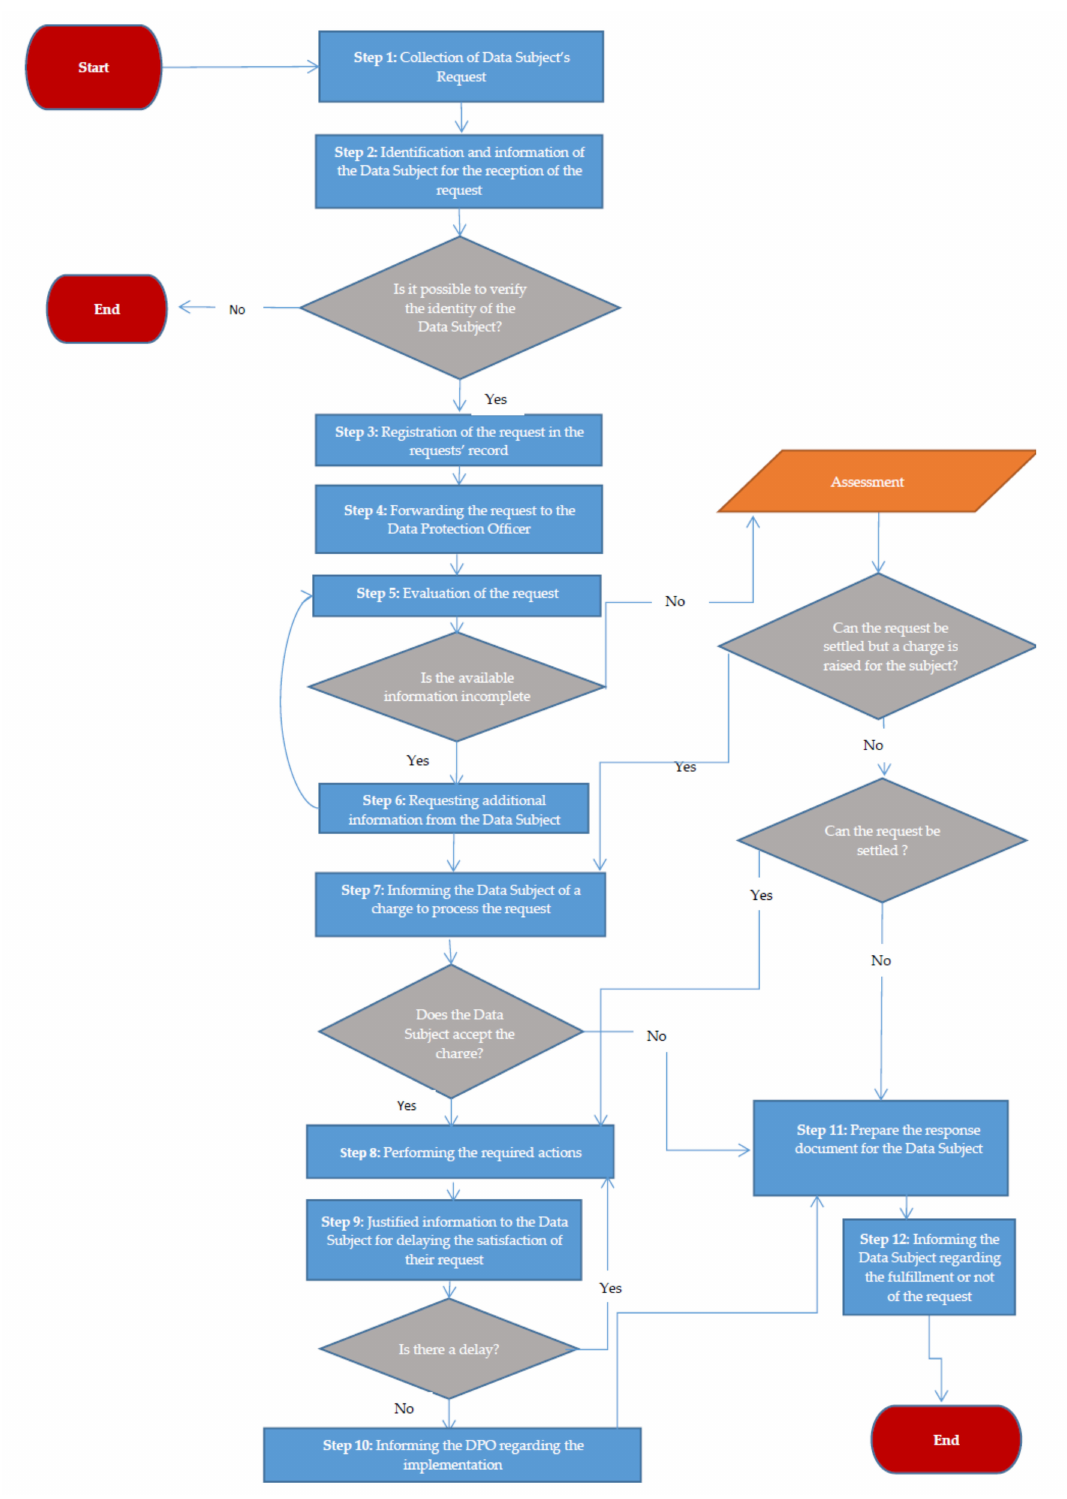
Figure 4. Process to satisfy the rights of data